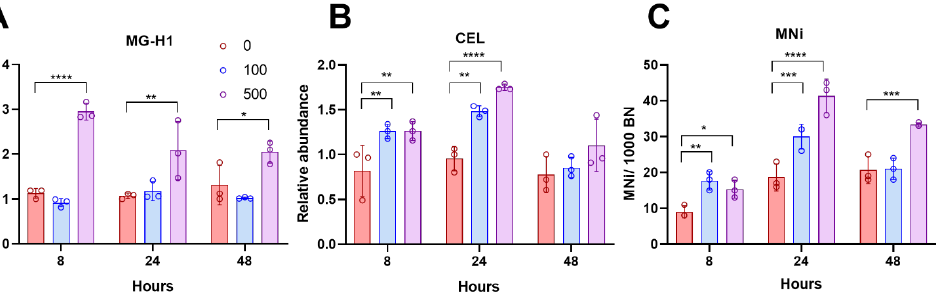
Figure 1. ( A ) MG-H1 concentration in whole-cell extracts at 8, 24, and 48 h normalised to control; ( B ) CEL concentration in whole-cell extracts at 8, 24, and 48 h normalised to control; ( C ) MNi formation, measured by CBMNcyt assay at 8, 24, and 48 h expressed as number of MNi/1000 Binucleated (BN) cells. Data are mean ± SD ( n = 3). A two-way ANOVA followed by a Dunnett post hoc was conducted to determine statistical significance. * p < 0.05, ** p < 0.01, *** p < 0.001, **** p <